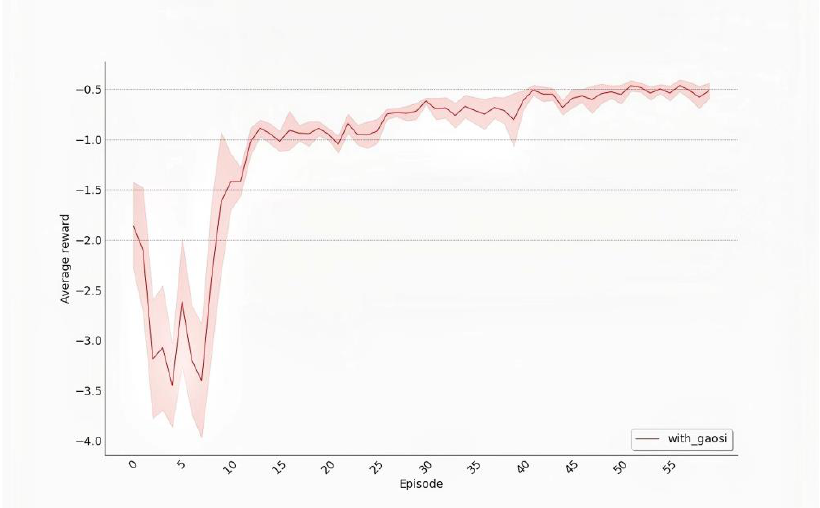
Figure 15. The change in average reward of the horizontal trajectory tracking task with the number of training wheels.